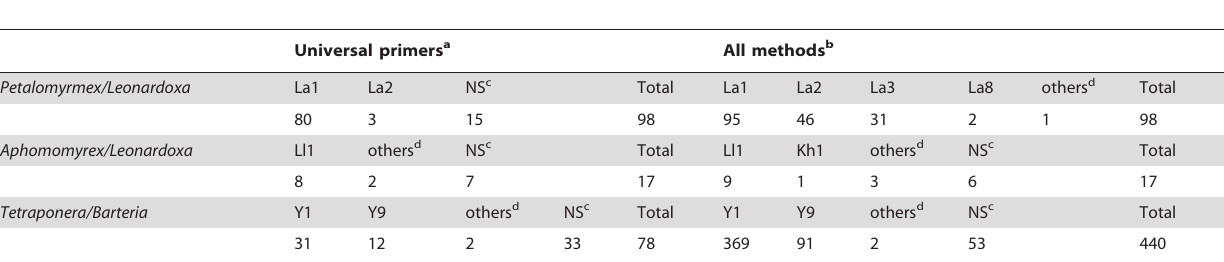
Table 2. Number of fungal samples in which the different MOTUs were detected using sequencing of the ITS region (ITS1, 5.8S, ITS2) of ribosomal